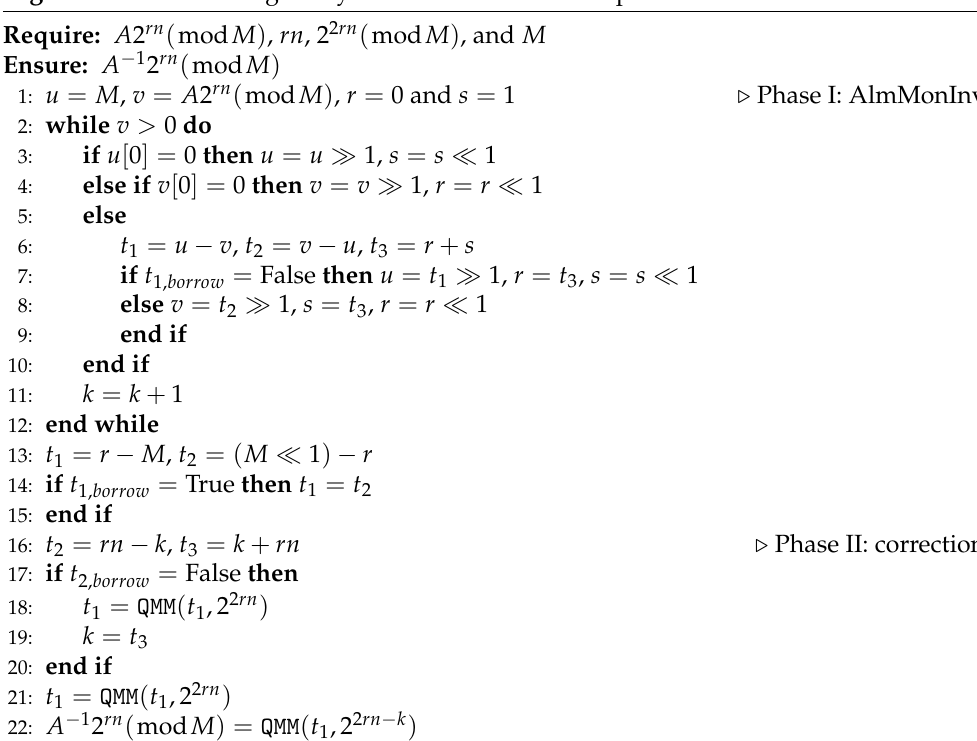
Algorithm 3 New Montgomery modular inversion